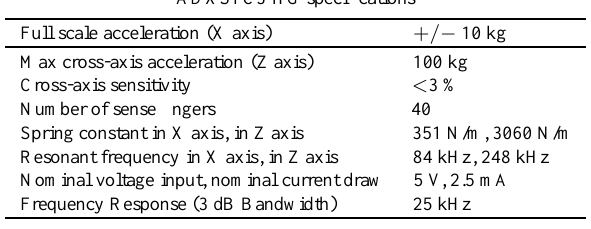
Table 1 ADXSTC3-HG specifications